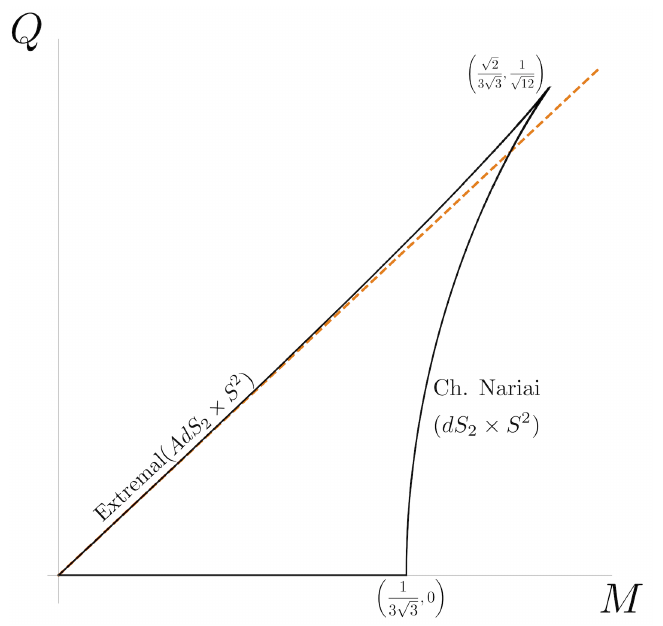
Figure 1 . The family of Reissner-Nordström-de Sitter black holes with the dimensionless parame- ters M ≡ GM with ‘ the dS length H − 1 . Sub-extremal solutions only exist inside , Q 2 ≡ Gg 2 Q 2 4 ‘ 4 4 π‘ 2 4 the shark-fin shaped region. The boundary of this allowed region has two branches: on the left branch one has extremal RN-dS black holes, which have a AdS 2 horizon. On the right branch 2 × S one has charged Nariai black holes for which the black hole and cosmological horizons coincide and become a dS 2 . The orange dashed line is the “lukewarm line” Q = M , where the two horizons 2 × S have the same temperature. Picture taken from